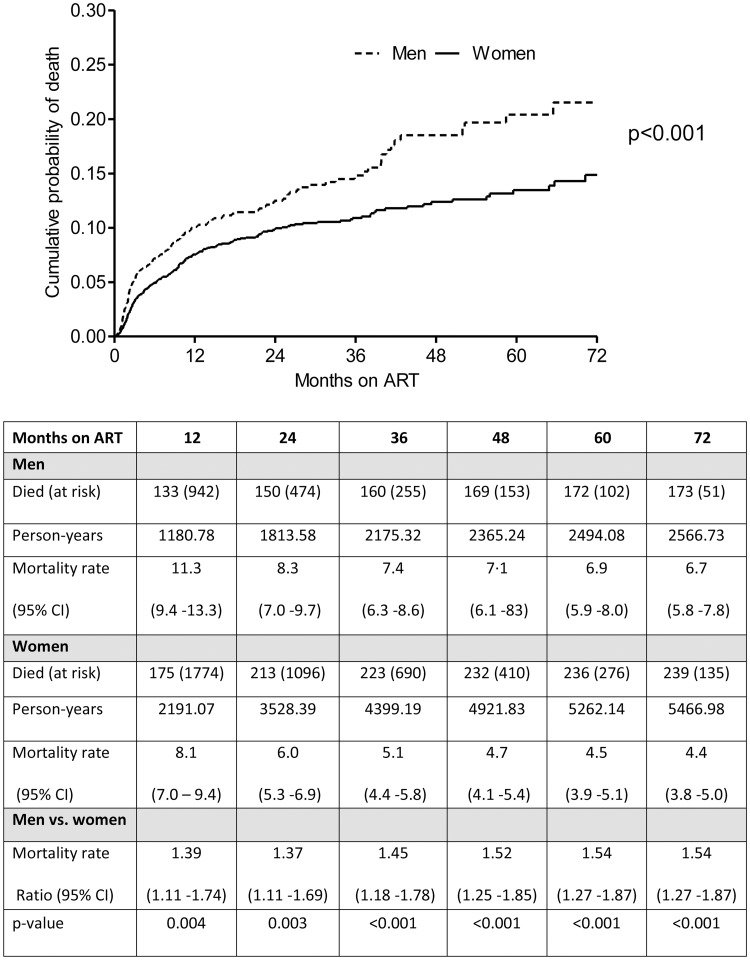
Kaplan-Meier estimates of cumulative annualised mortality rates between men and women accessing ART.